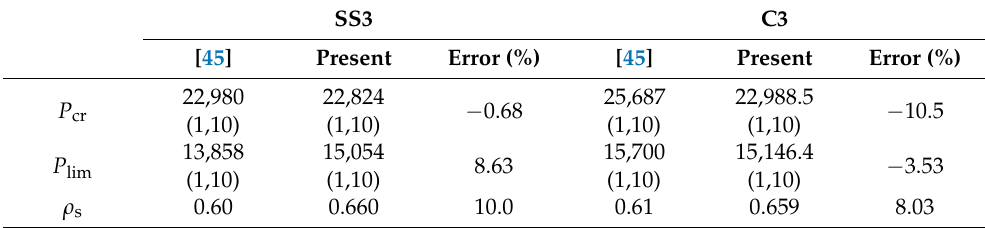
Table 4. Comparison of the axial buckling results (N/m) for the stringer-stiffened cylindrical shell AS-2. SS3